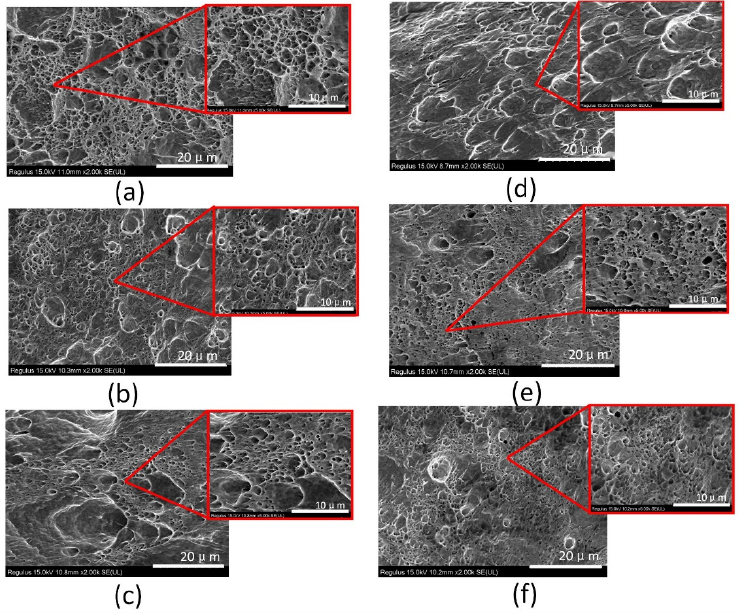
Figure 9. Fracture surface morphology of copper deposits with temperatures from − 5 °C to 5 °C after strength testing: ( a ) − 5 °C, ( b ) − 3 °C, ( c ) − 1 °C, ( d ) 1 °C, ( e ) 3 °C, ( f ) 5 °C. The dimple shape, size, after strength testing: ( a ) − 5 ◦ C, ( b ) − 3 ◦ C, ( c ) − 1 ◦ C, ( d ) 1 ◦ C, ( e ) 3 ◦ C, ( f ) 5 ◦ C. The dimple shape, depth, width and uniformity are quite different at various temperatures. size, depth, width and uniformity are quite different at various